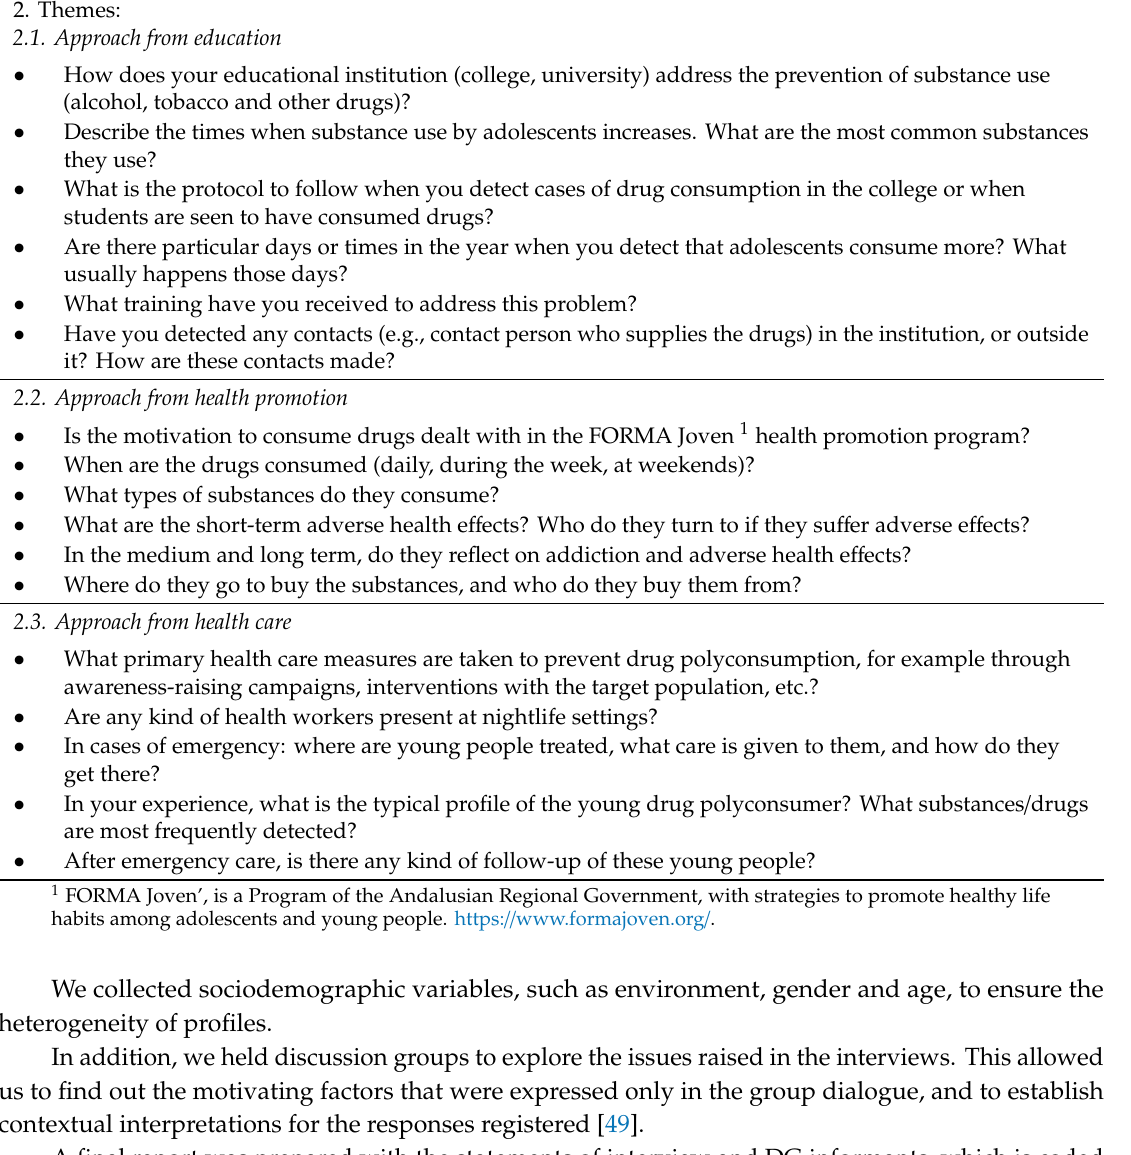
Table 2. Script for social informant